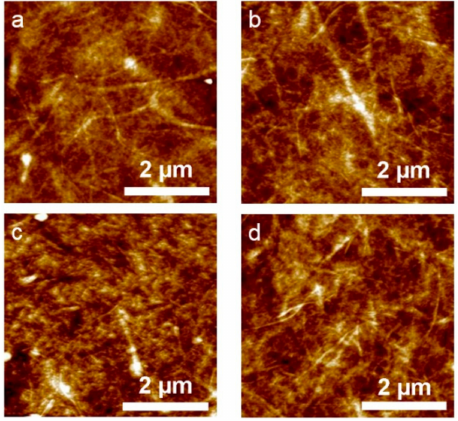
Figure 1. TEMPO-oxidized cellulose nanofibrils (CNF) and corresponding films for: ( a ) bleached birch kraft pulp (BBK); ( b ) bleached kraft pulp extracted with water at 240 ◦ C for 2 min (BBK240.2); ( c ) bleached kraft pulp extracted with water at 240 ◦ C for 10 min (BBK240.10); ( d ) unbleached kraft pulp extracted with water at 240 ◦ C for 10 min (UBK240.10).